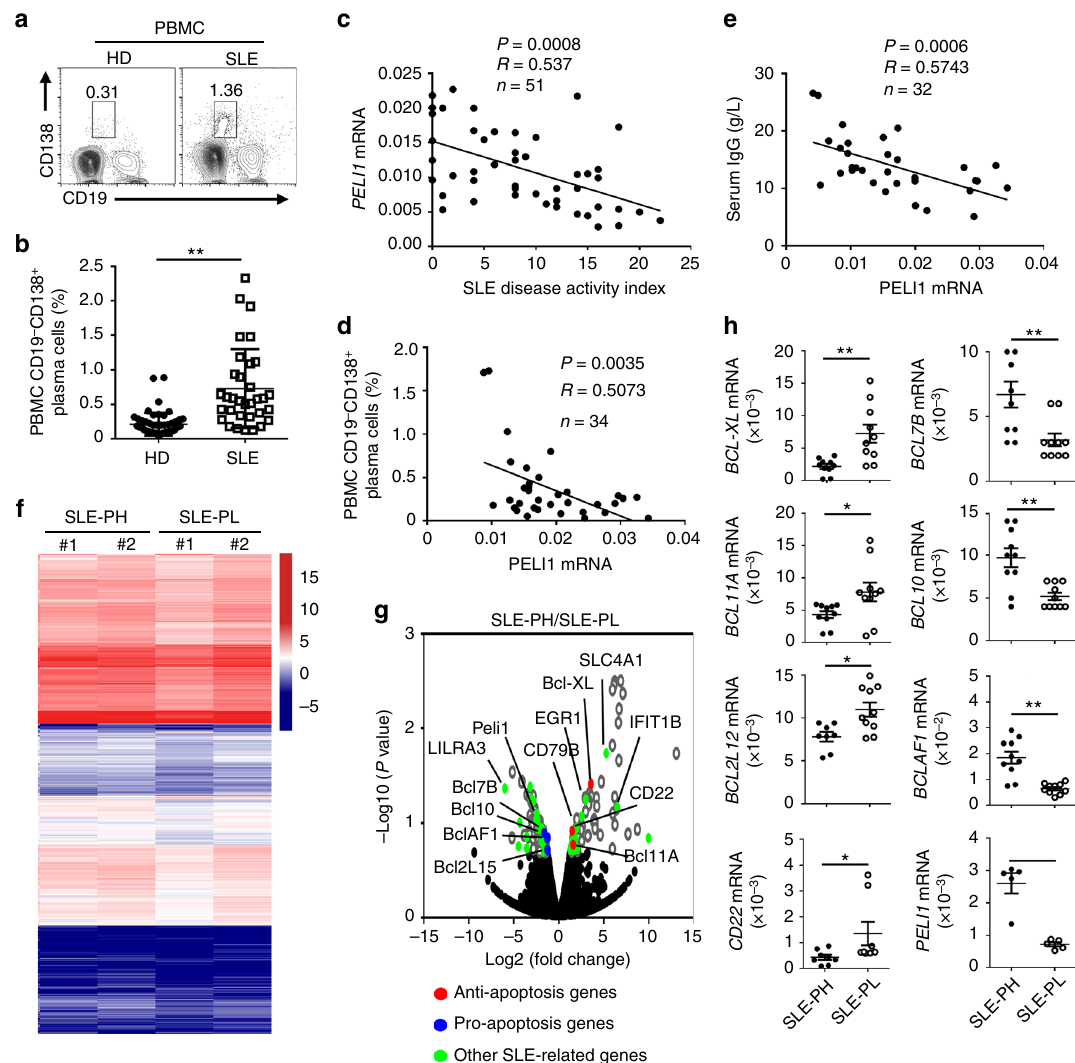
Fig. 8 PELI1 expression is negatively correlated with SLE disease activity. a , b Flow cytometric analysis of the frequencies of CD19 − CD138 + plasma cells in peripheral blood mononuclear cells (PBMCs) from health donors (HD) and SLE patients. Data are presented as a representative plot ( a ) and summary graph ( b ). c – e Correlation analysis of the PELI1 mRNA expression in PBMCs with the disease activity ( c ), plasma cells frequencies ( d ), and serum IgG levels ( e ) in SLE patients. f Heat map showing differentially expressed genes in PBMCs that isolated from SLE patients with Peli1 high or Peli1 low mRNA expression (SLE-PH or SLE-PL). g Volcano graphs showing the genes differentially expressed in PBMCs between SLE-PH and SLE-PL. h QPCR determining the relative expression of the indicated apoptosis-related and Peli1 genes in PBMCs of SLE-PH and SLE-PL patients. Each dot represents a value of the gene epression results from SLE-PH or SLE-PL patients. Data were normalized to a reference gene, ACTIN . Data are shown as the mean ± SEM based on three independent experiments. Two-tailed Student ’ s t- tests were performed. * P < 0.05 and ** P <